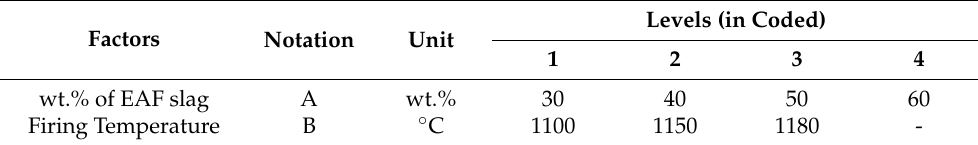
Table 2. Factors and their respective number of levels investigated in general full factorial design. Factors Notation